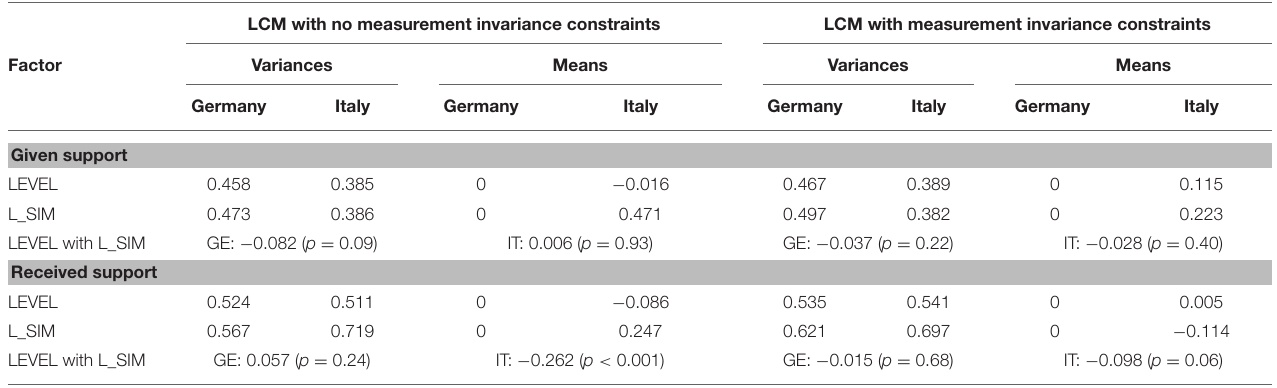
TABLE 5 | Variances and means of second-order factors for the given and received support similarity models. LCM with no measurement invariance